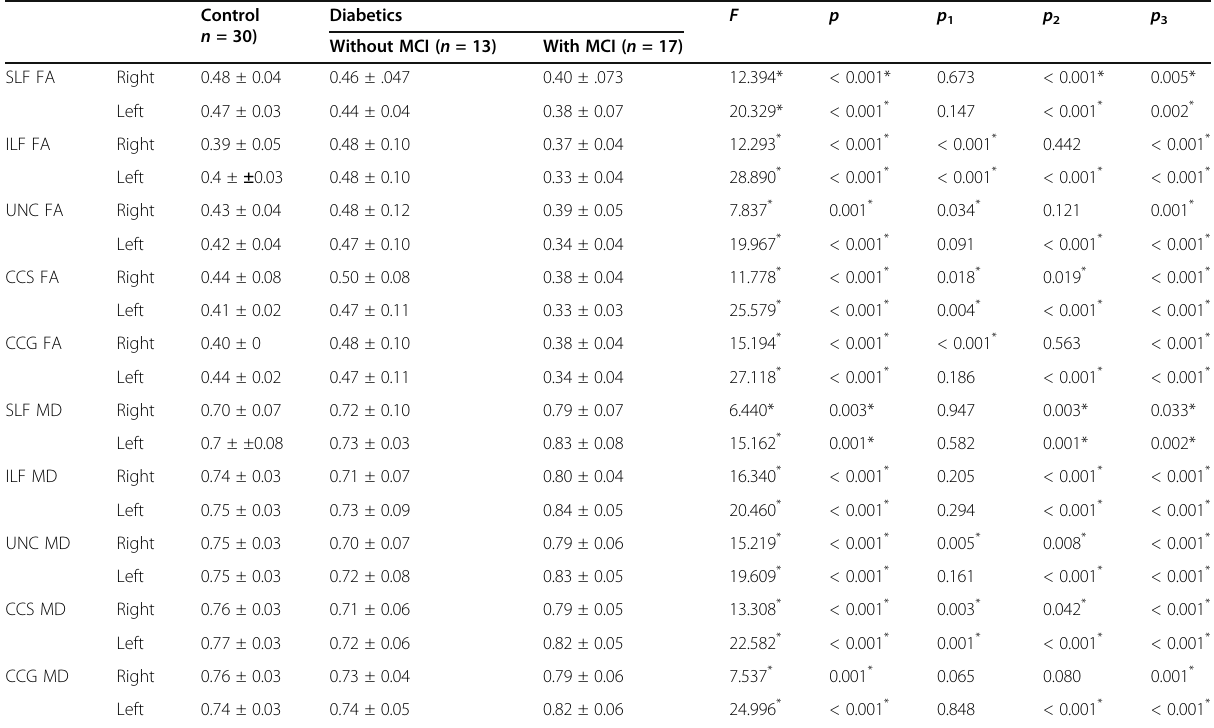
Table 4 Fractional anisotropy and mean diffusivity of controls, diabetics without mild cognitive impairment, and diabetics with mild cognitive impairment Control n =